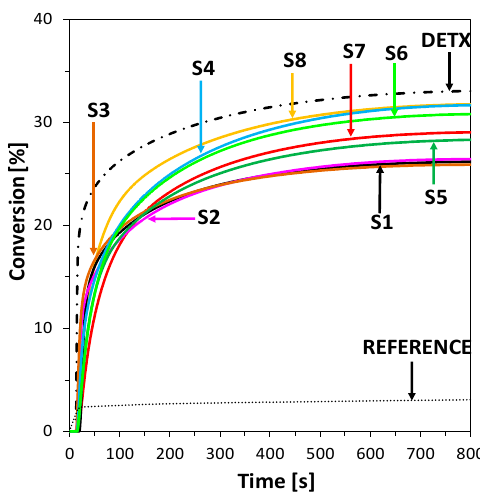
Figure 14. Profiles of CADE epoxy group conversion with HIP (1 wt.%) and 2-amino-4,6-diphenyl-pyridine-3-carbonitrile derivatives (0.1 wt.%) under 405 nm LED (intensity at the surface of sample 25 mW/cm 2 ) irradiation, calculated from photo-DSC data. Irradiation begins at t = 10 s.